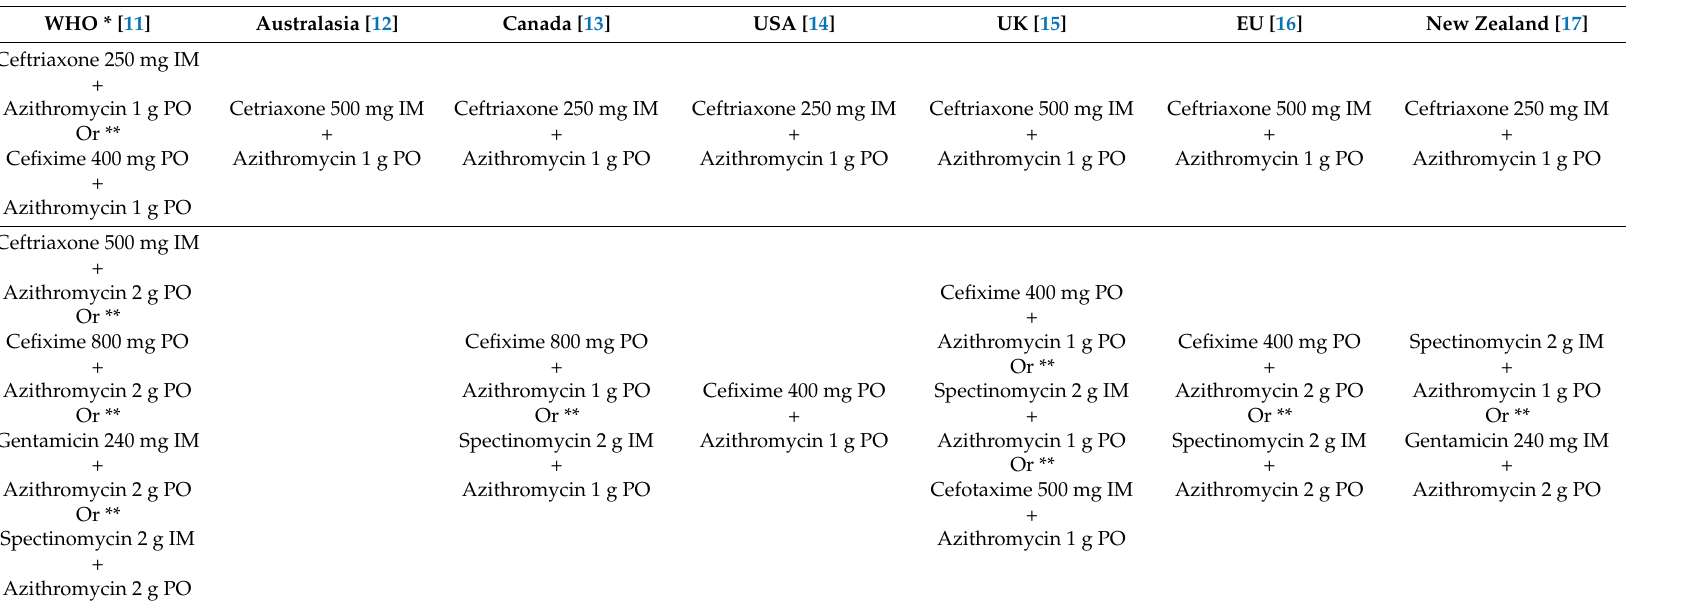
Table 1. Different treatment guidelines for gonorrhea worldwide (all single